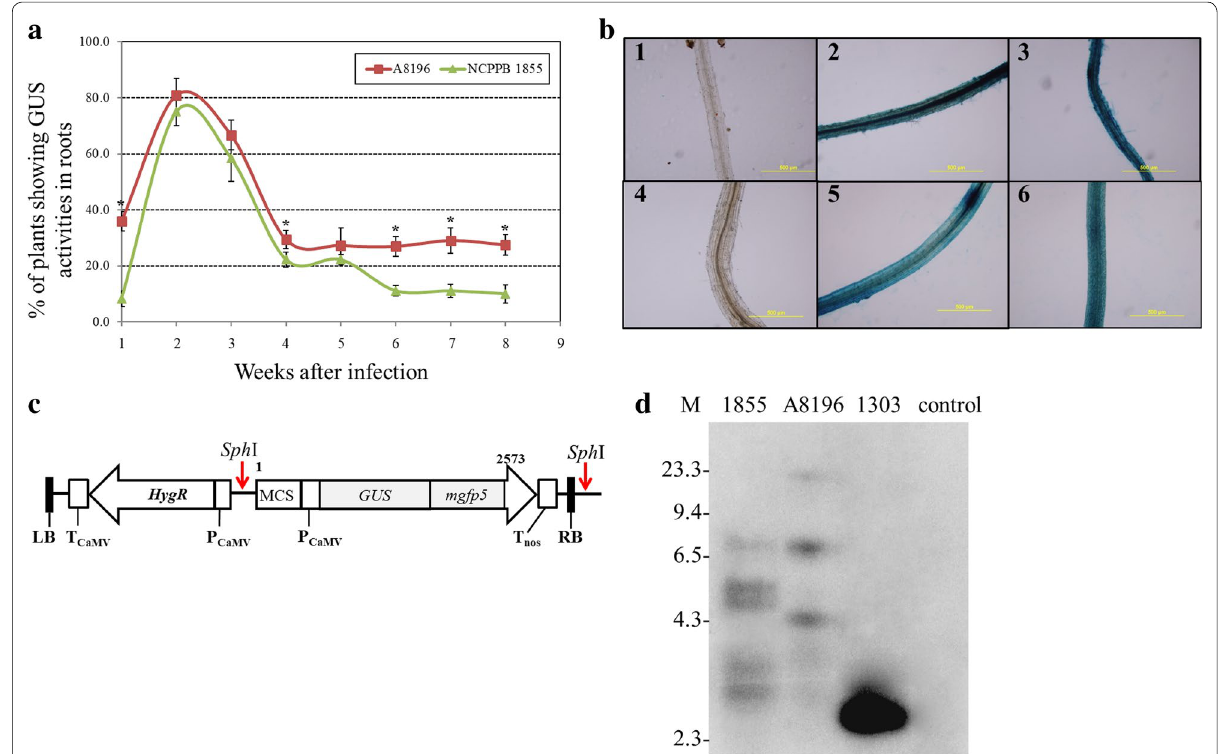
Fig. 4 Transformation efficiency and Southern blotting results of hydroponically grown ice plants after infection with the A. rhizogenes A8196 or NCPPB 1855 strain harboring the pCAMBIA1303 binary vector. a Percentage of plants showing GUS activity in hydroponically grown plant roots on infection with A. rhizogenes A8196 or NCPPB 1855 from 1 to 8 weeks after infection. About 16–20 ice plants were infected with either A. rhizogenes strain for each independent transformation assay. Data are mean SD from at least three independent experiments. *P < 0.05 comparing A. ± rhizogenes A8196 infected plants and A. rhizogenes NCPPB 1855 infected plants under the same week after infection based on pairwise Student t ‑test. b Representative GUS staining of ice plant roots after infiltration with mock control (b1, b4), infection with A. rhizogenes A8196 (b2, b5) or NCPPB 1855 (b3, b6). Mock control or bacteria‑infected root fragments from plants 1 week after treatments are shown in b1 to b3 and 8 weeks after treatments in b4 to b6. Bar 500 μm. c T‑DNA regions of the binary vector pCAMBIA1303 showing the positions of Sph I site. d Genomic Southern = blot analysis of T‑DNA integration 8 weeks after infiltration. Genomic DNA (30 μg/lane) was digested with Sph I and hybridized with 32 P‑labeled GUS probe. M: λDNA Hin dIII‑digested marker; 1855: NCPPB 1855‑infected roots; 8196: A8196‑infected roots; 1303: gel‑purified Sph I‑digested fragment of pCAMBIA1303; control: mock control